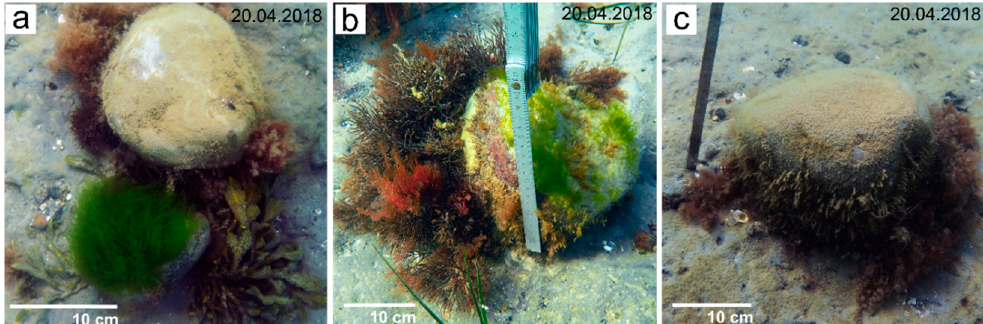
Figure 5. ( a – c ) Overturned cobbles on top of the gyttja in SA1. Free patches of space on top of the cobbles enable the growth of early successional macroalgae, leading to a mosaic of different suc- cessional stages within the